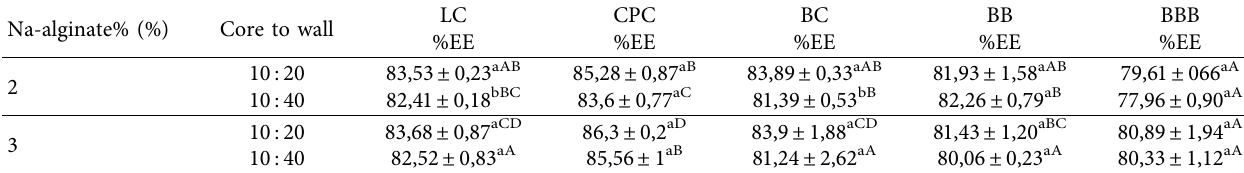
Table 4: Encapsulation efficiency (%EE) of starter culture at different encapsulation